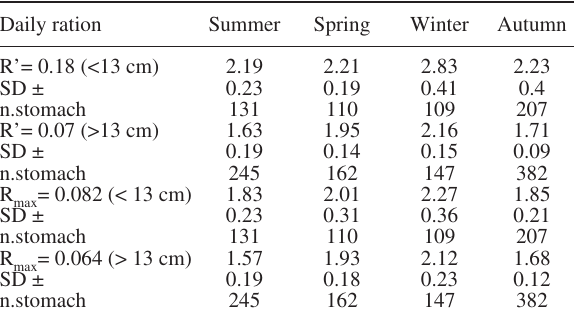
Table 3. – Daily ration estimates (expressed as percentage of fish body weight - %BW) obtained with the Eggers (1979) model, both with the direct estimation of the consumption rate R and with max the instantaneous evacuation rate from bibliographic review R’ . SD, standard